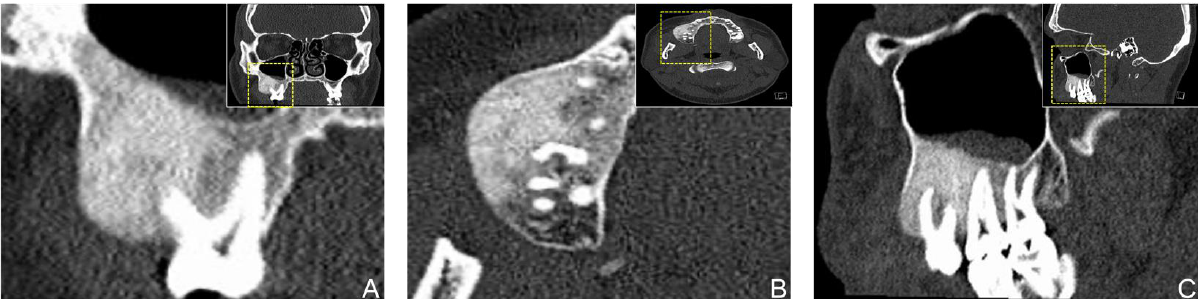
Figure 5. Coronal ( A ), axial ( B ), and sagittal ( C ) reconstruction of a study participant’s computed tomography (CT) showing a fibrous dysplasia in the posterior maxilla. Clinically, the patient presented with swelling associated with tenderness and hypoesthesia.